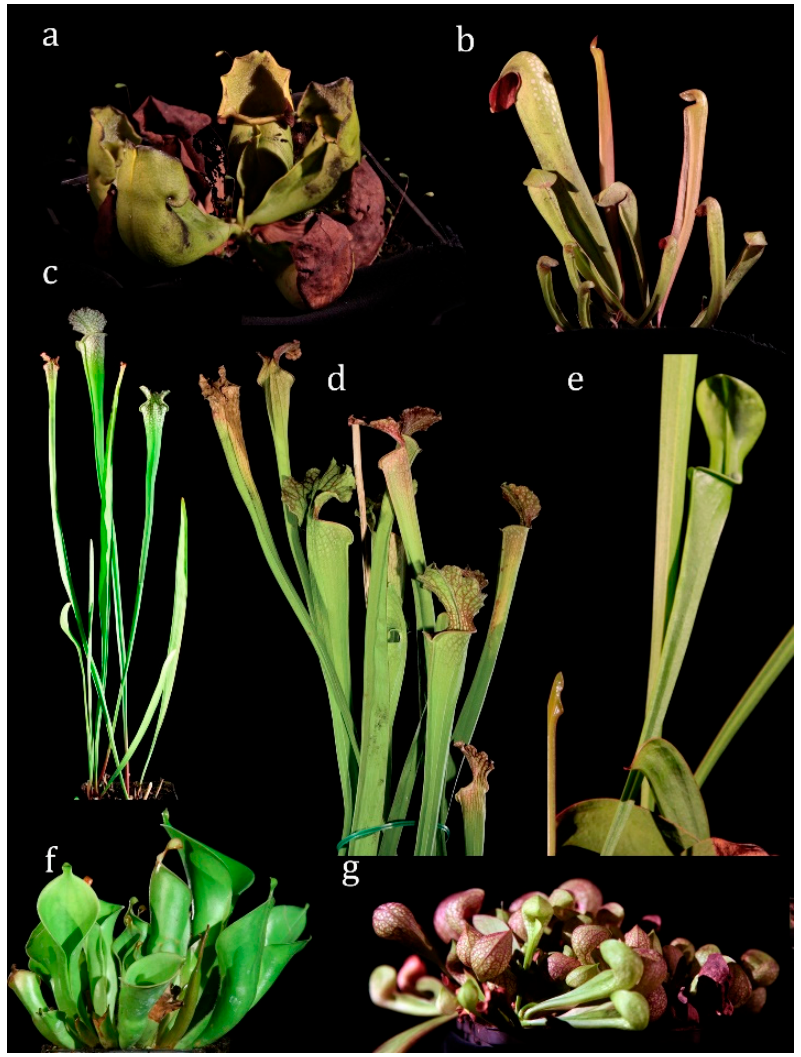
Figure 1. Habitus of tested Sarraceniaceae. ( a ) Sarracenia purpurea ssp. purpurea ( b ) Sarracenia minor ( c ) Sarracenia leucophylla ( d ) Sarracenia flava ( e ) Sarracenia oreophila ( f ) Heliamphora nutans ( g ) Sarracenia psittacina .